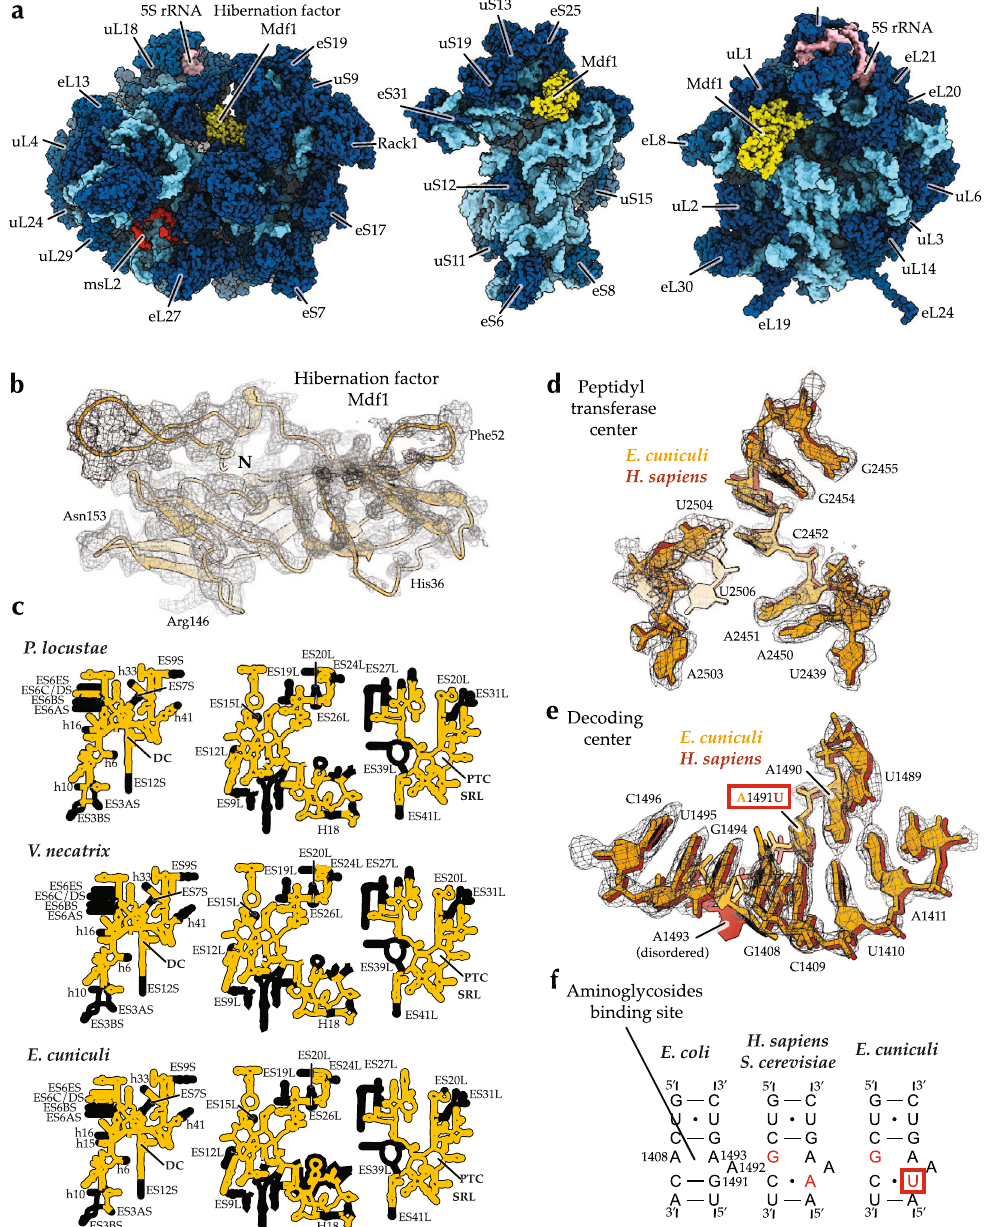
ribosomes in complex with the hibernation factor Mdf1 (pdb id 7QEP). b The map of the hibernation factor Mdf1 bound to E. cuniculi ribosomes. c Secondary structure diagrams compare rRNA reduction in microsporidian species with known ribosome structures. The panels indicate the location of rRNA expansion segments (ES) and ribosomal active centers, including the decoding site (DC), the sarcin-ricin loop (SRL), and the peptidyl-transferase center (PTC). d The electron density corresponding to the peptidyl-transferase center of E. cuniculi ribosomes shows that this catalytic site has the same structure in the parasite E. cuniculi and its hosts, including H. sapiens . e , f The electron density corresponding to the decoding center ( e ) and schematic structures of the decoding center ( f ) illustrate that E. cuniculi have U1491 residue instead of A1491 ( E. coli numbering) in many other eukaryotes. This variation suggests that E. cuniculi may have sensitivity to the antibiotics targeting this active